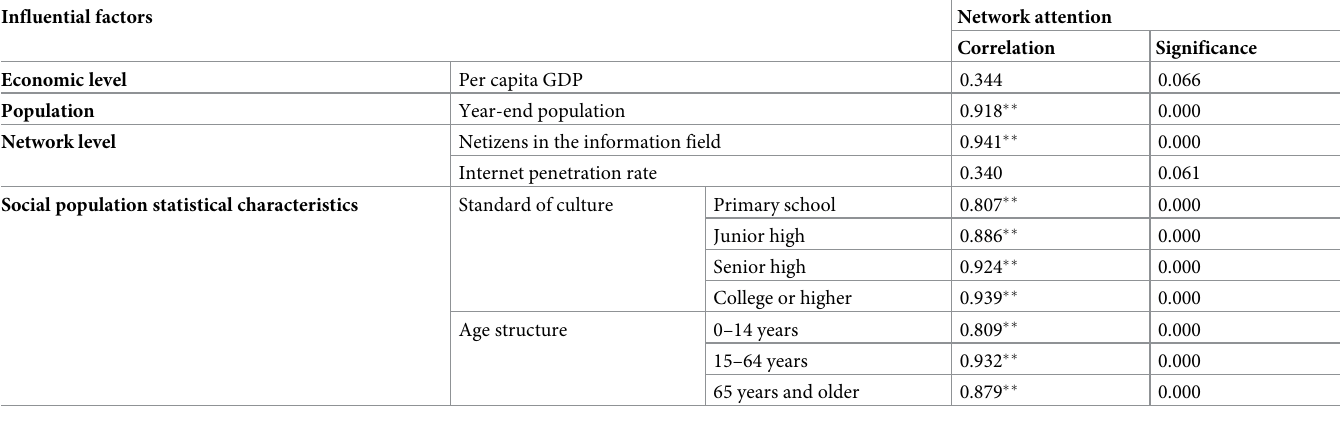
Table 2. Correlation analysis of the factors that influence COVID-19 network